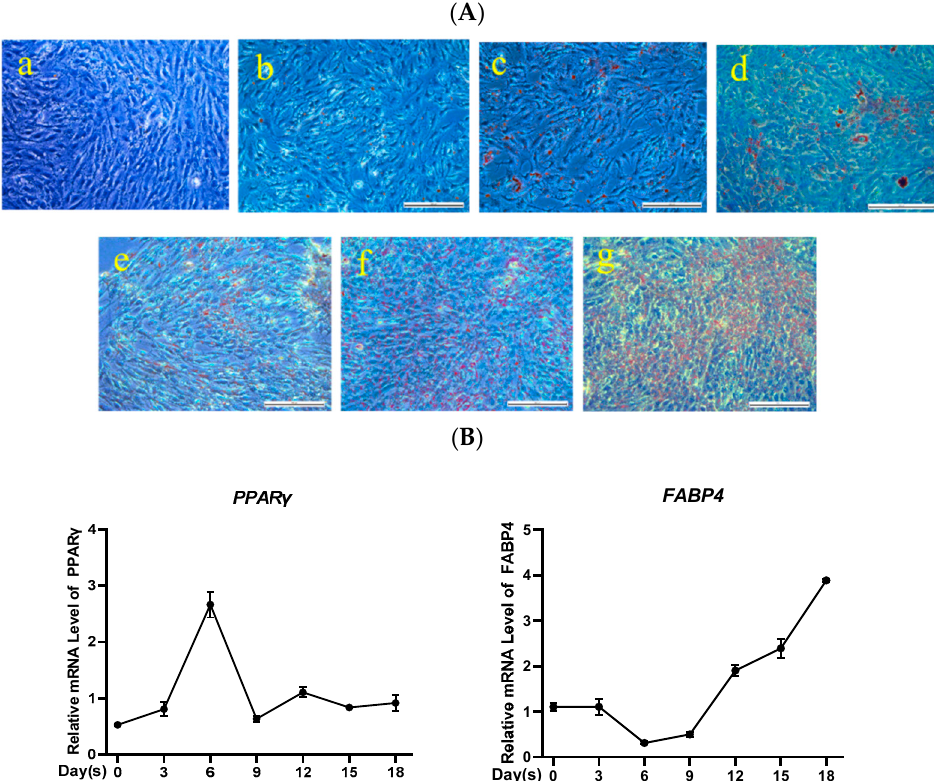
Figure 1. Adipogenic differentiation of pBMSCs. ( A ) Oil Red O was used to stain the pBMSCs, differentiated on day 0 ( A-a ), 3 ( A-b ), 6 ( A-c ), 9 ( A-d ), 12 ( A-e ), 15 ( A-f ), and 18 ( A-g ) (bar = 200 µ m). ( B ) PPAR γ and FABP4 mRNA levels on the relevant days were examined by qRT-PCR.